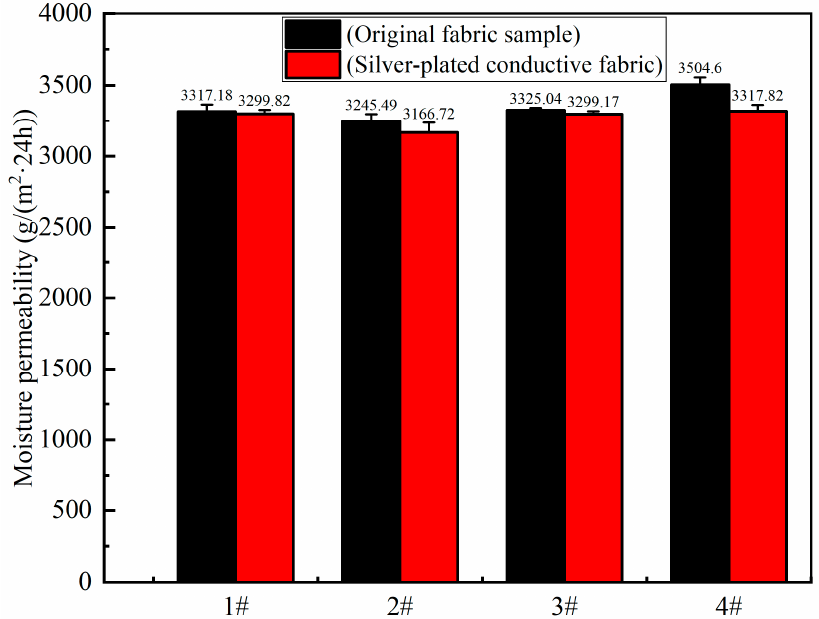
Figure 5. The original state of the four fabrics and the moisture permeability test results of the silver- plated conductive